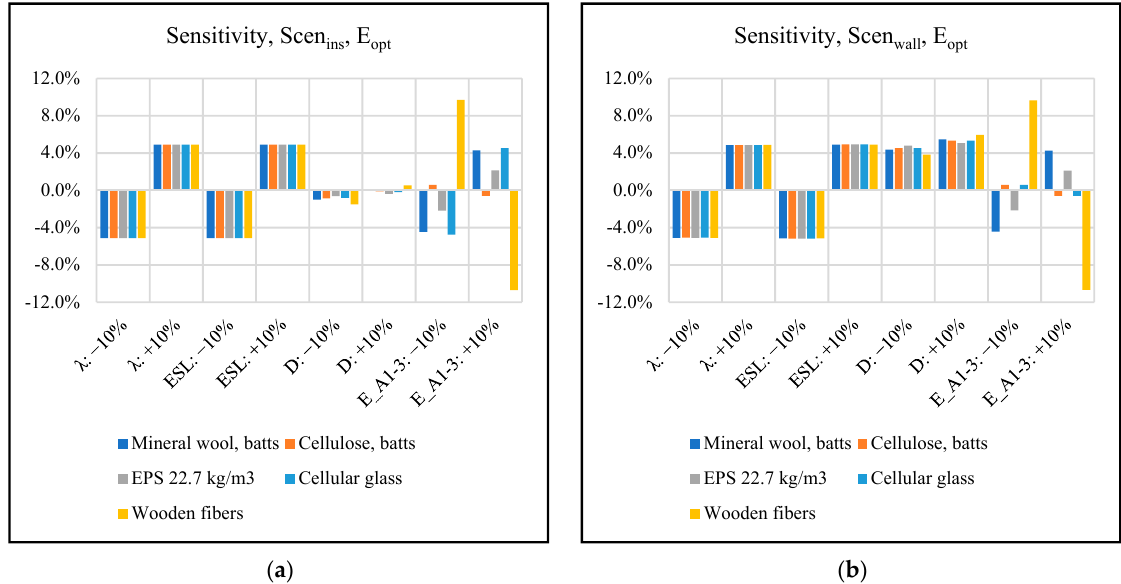
Figure 5. Sensitivity analysis of E opt for all materials. ( a ) is for Scen ins , and ( b ) is for Scen wall as described in Table 4. The results are nearly identical for the three cities, but these are specifically for Qaqortoq with district heating.